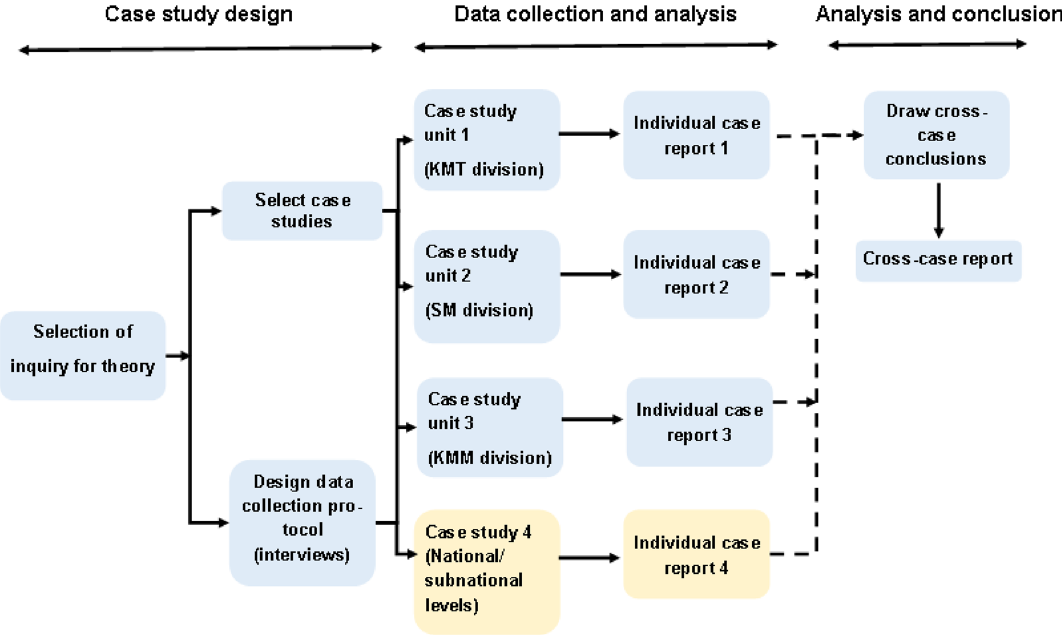
Fig. 4 Case study procedure from design to results in southeastern Sri Lanka (KMT = Kalmunai T; SM = Sainthamaruthu; KMM = Kalmunai M). Source Adapted from Yin (2013, p.